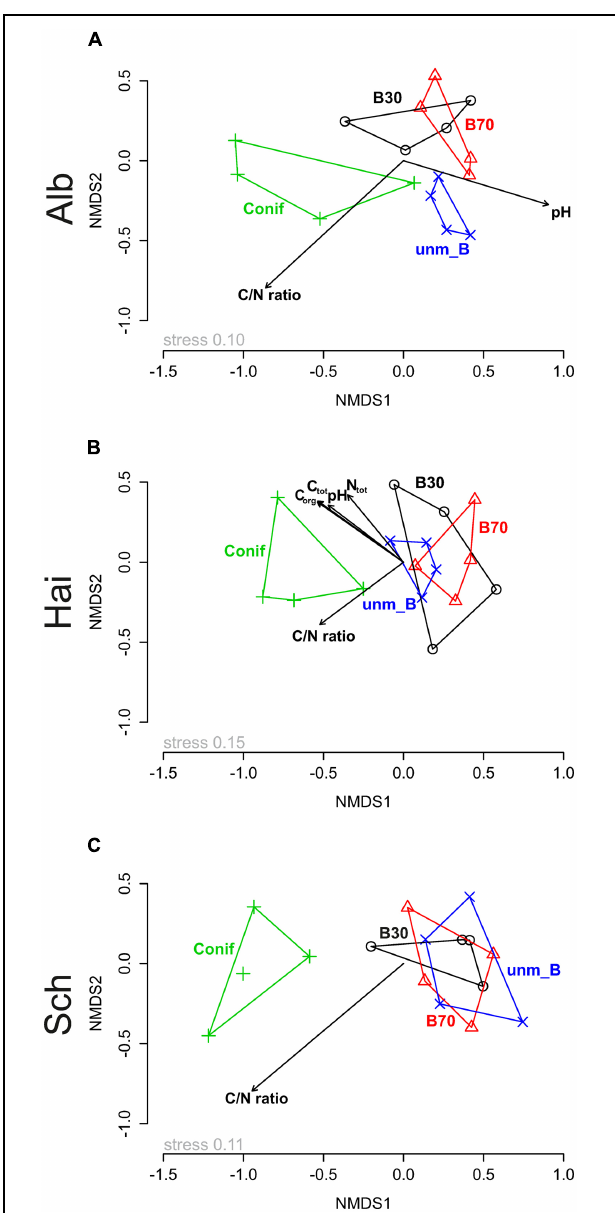
FIGURE 1 | Non-metric multidimensional scaling (NMDS) ordination displaying fungal community composition across the three study sites, (A) Swabian Alb (Alb), (B) Hainich-Dün (Hai), and (C) Schorfheide-Chorin (Sch), in relation to forest management type (o B30–young beech forest, (cid:2) B70–old beech forest, + Conif–coniferous forest, x unm_B–unmanaged beech forest) and soil properties ( C tot –total carbon, C org –organic carbon, N tot –total nitrogen, C/N ratio–ratio of organic carbon to total nitrogen and pH). Stress values represent